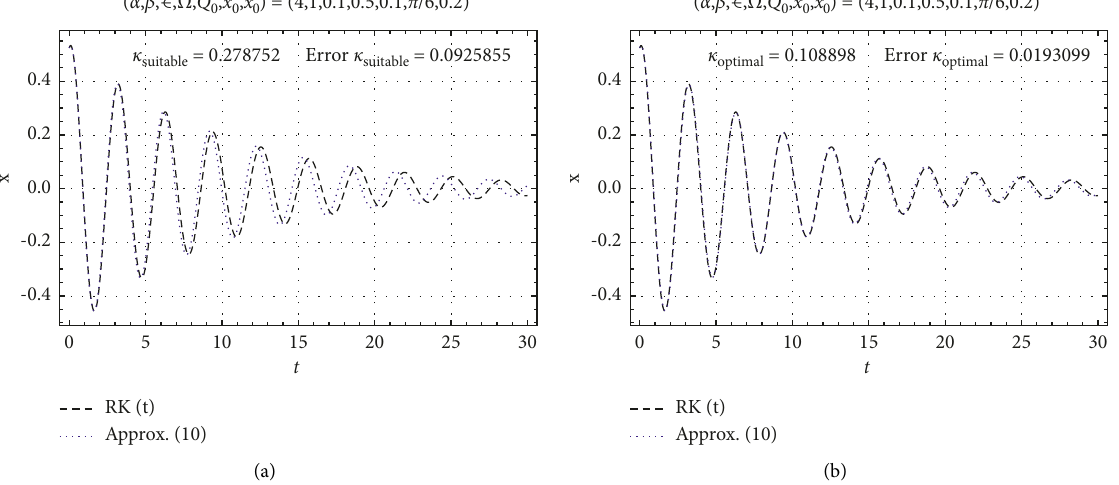
Figure 2: The profile of the approximation (12) using the values of κ against t for α , β , ε , (